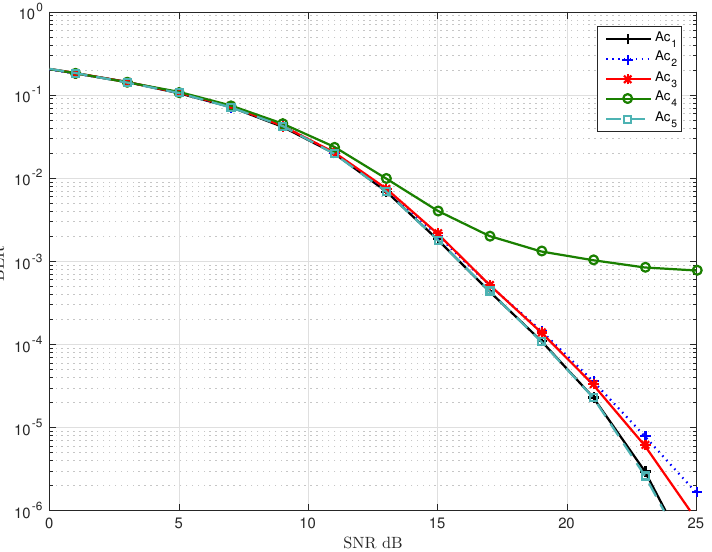
Figure 11. BER vs. SNR comparison of the proposed conventional OFDM communication system among each of the couplings with N p = 16, FFT = 256, 64 QAM and BW = 200